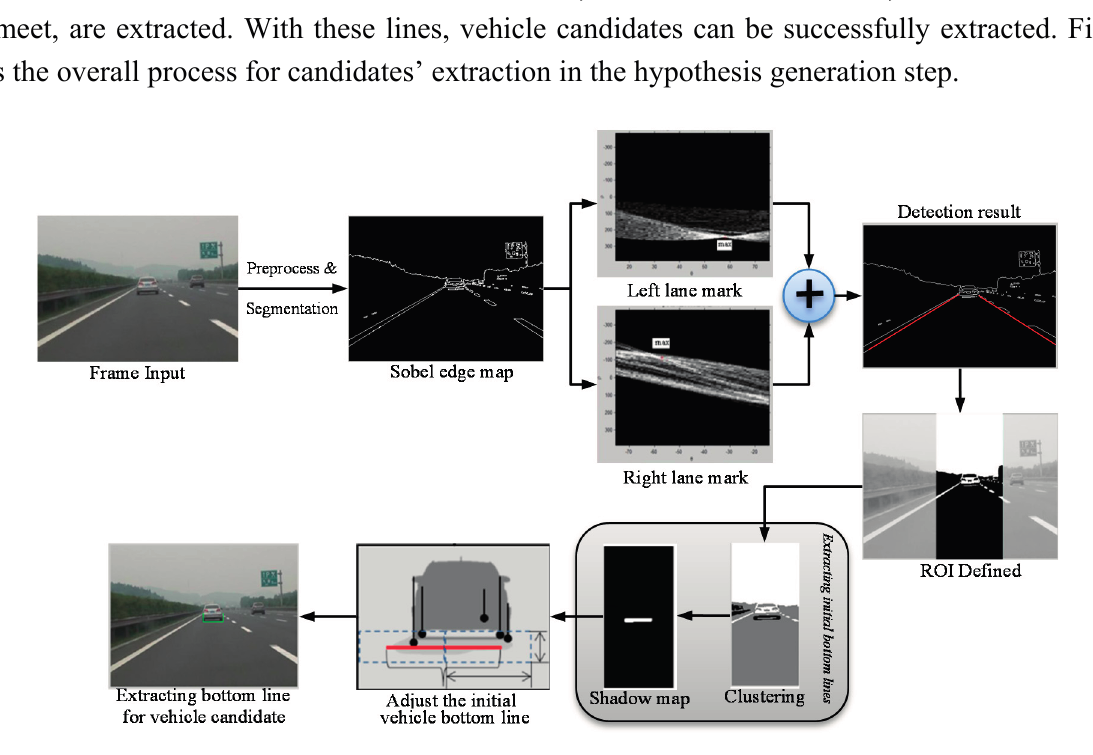
Figure 3. Flow chart of the forward vehicle candidate